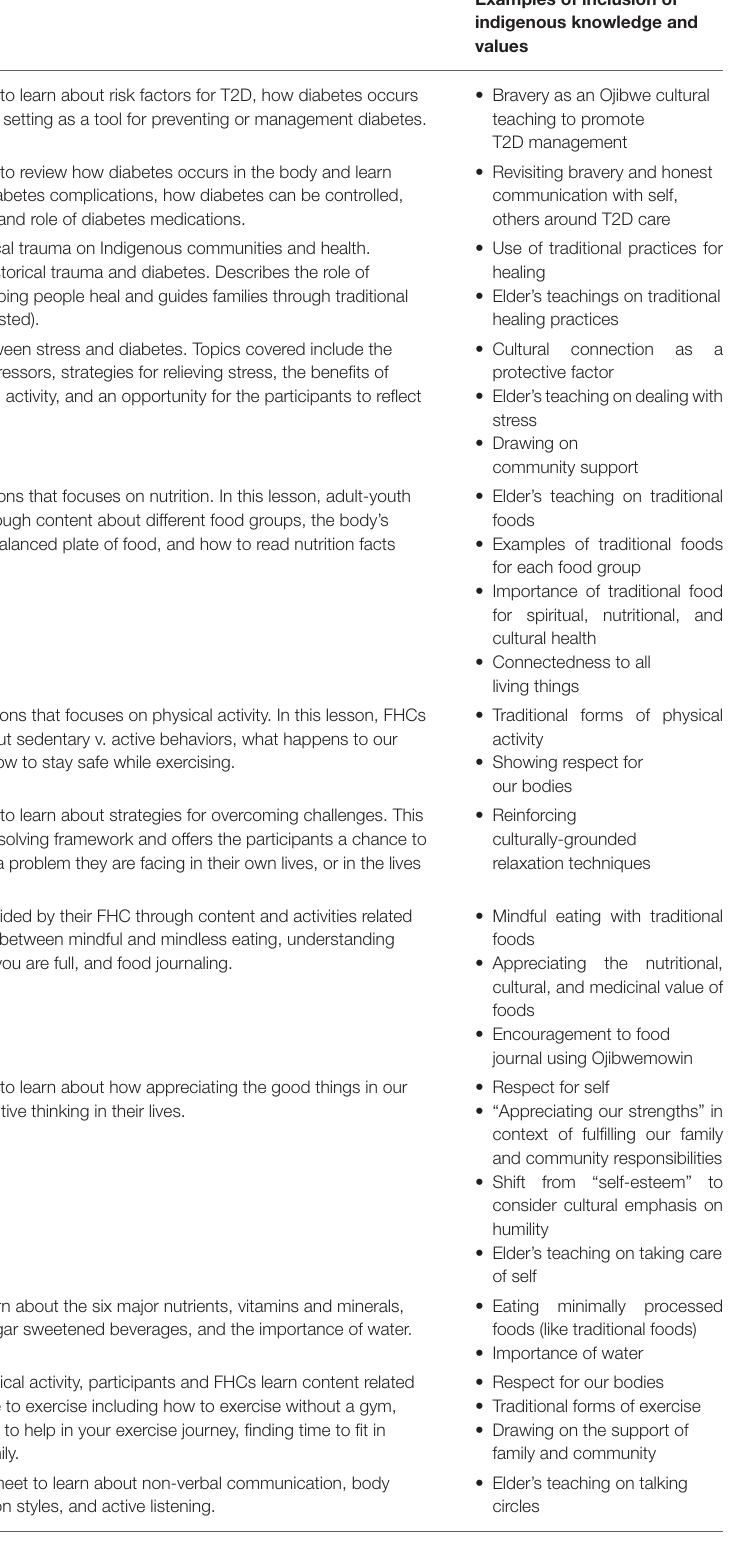
TABLE 2 | TOD Great Lakes curriculum outline.